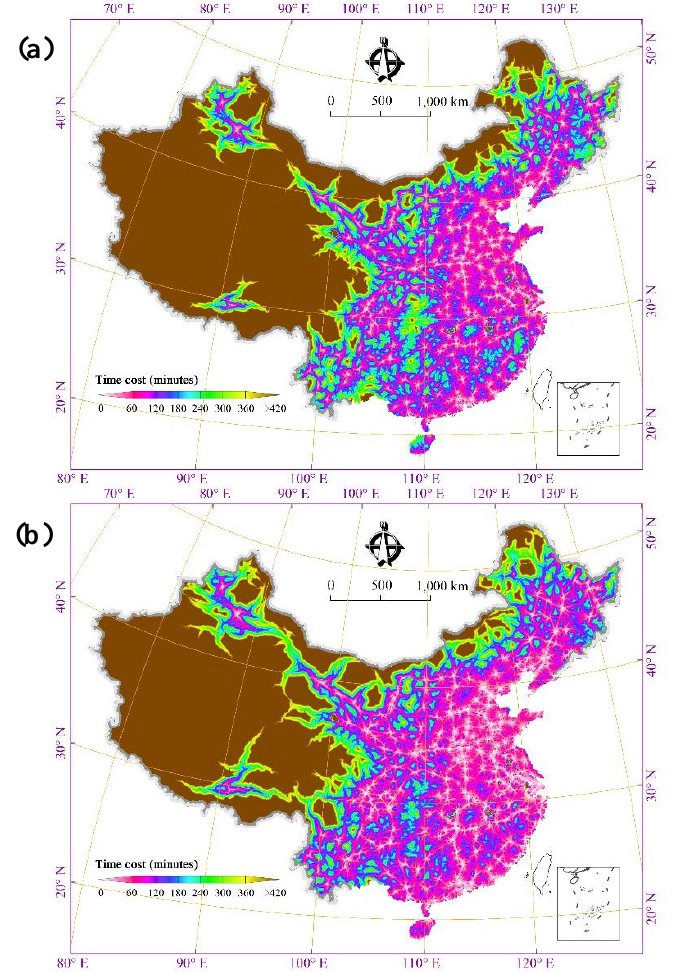
Figure 2. Spatial pattern of regional accessibility in relation to time cost in China for the year ( a ) 2000 and ( b )